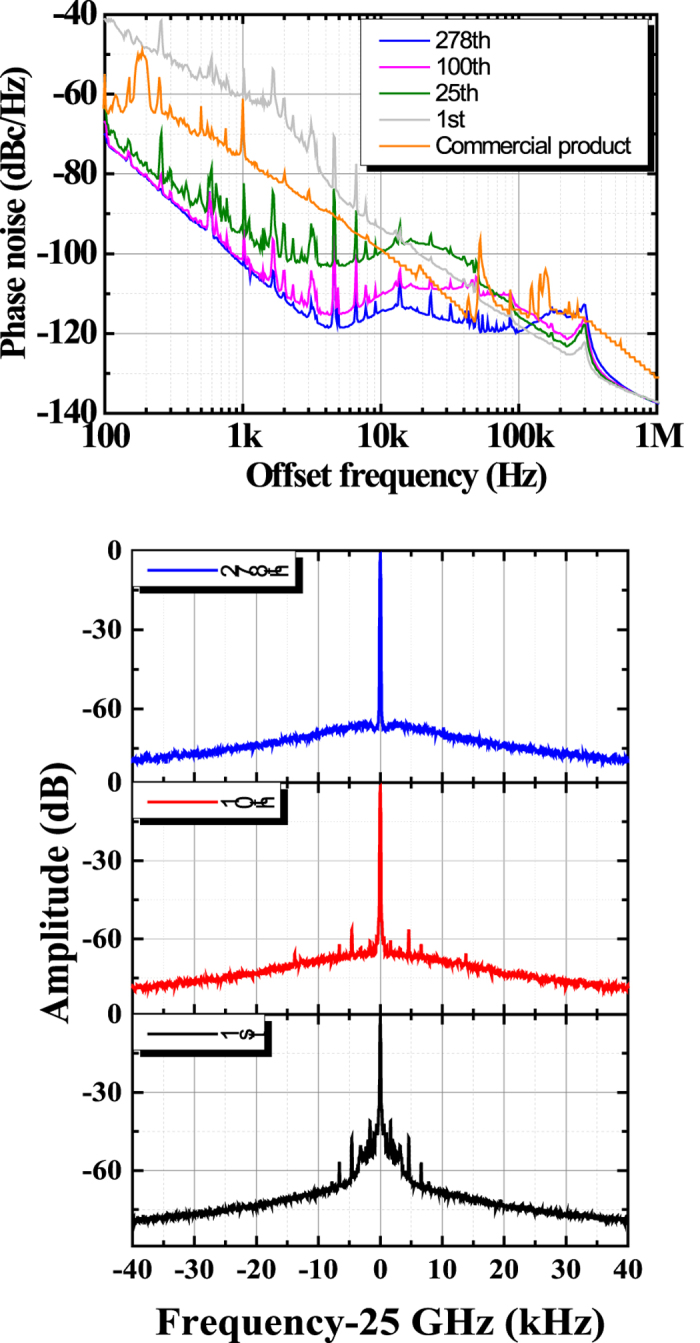
Dependence of experimental phase-noise spectra of the 25-GHz millimetre waves on the reference comb mode number.(a) Measured phase noise of the commercial product (orange trace) and of SG 1 feeding back with the 1st mode (grey trace), 25th mode (green trace), 100th mode (pink trace), and 278th mode (blue trace) of the EOM-OFC. (b) Measured millimetre-wave spectrum via SG 1 in the 1st mode (black trace), 10th mode (red trace), and 278th mode (blue trace).